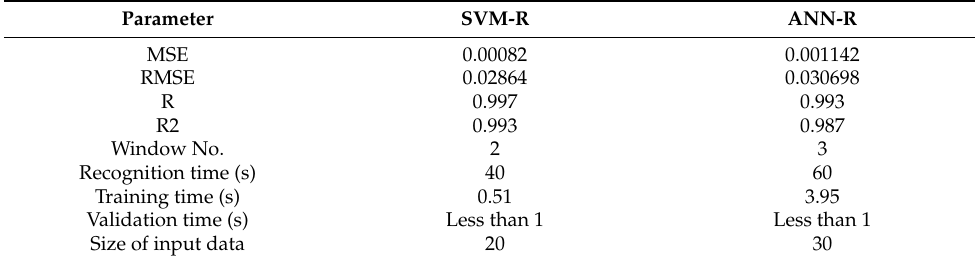
Table 8. Performance comparison of regression